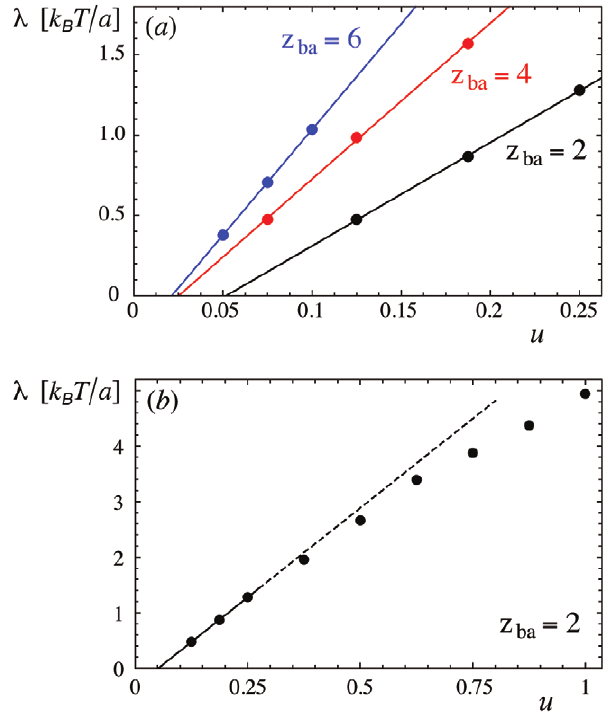
Figure 6. Extrapolated line tensions l for the symmetric double-well potential with rescaled depth u ~ u 1 ~ u 2 of the potential wells. The data points are from Monte Carlo simulations with the rescaled well width z we ~ 0 : 5 and the rescaled well separations z ba ~ 2 , 4 and 6. (a) For small and intermediate values of u , the line tension l is linear in u ; (b) At large values of u , the line tension l is a nonlinear function of u . Note that the first three data points are identical with the black data points in subfigure (a). The line tension vanishes at the critical potential depth u c for domain formation, which depends on the separation z ba and width z we of the two potential wells (see eqs. (14) and (15)).